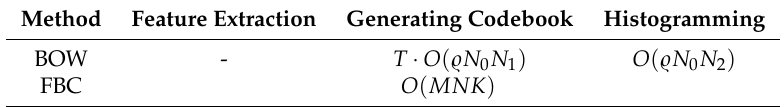
Table 1. Comparison of the computational complexity of the FBC and BOW